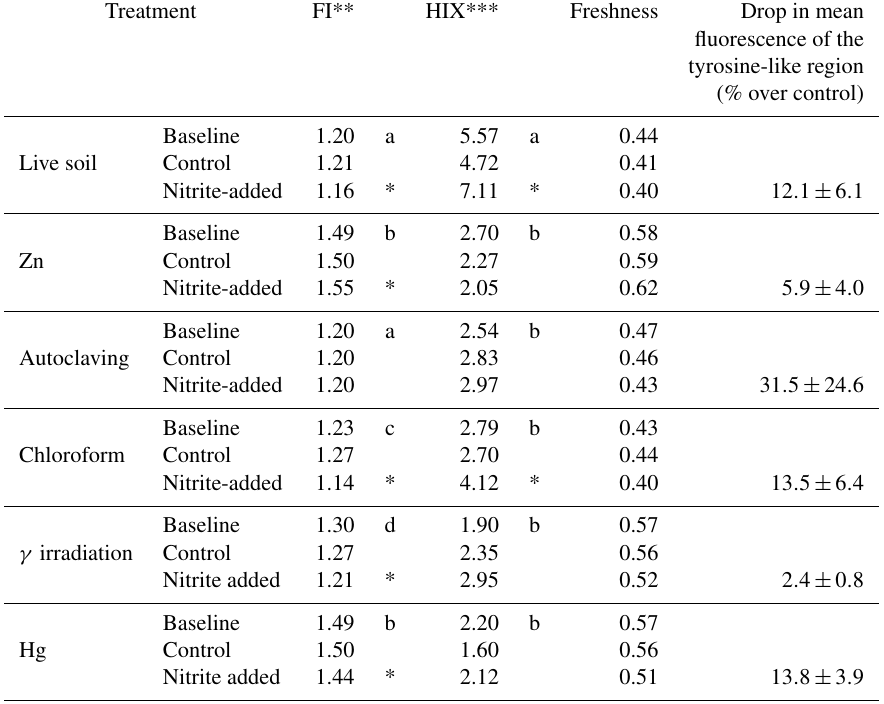
Table 1. Characteristics of dissolved organic matter in soil extracts from incubations of peat from Quistococha, Peru. FI, HIX, and freshness indices were calculated as described in the Methods section. The “tyrosine-like” region is defined at an excitation of 270–275nm and an emission of 304–312nm (Fellman et al., 2010). The signal for that region was averaged across replicates and expressed as percent difference between NO − additions and controls ± SD of replicates. A drop in the signal intensity was consistently apparent but clear differences between 2 the treatments were not, due to high standard deviation of